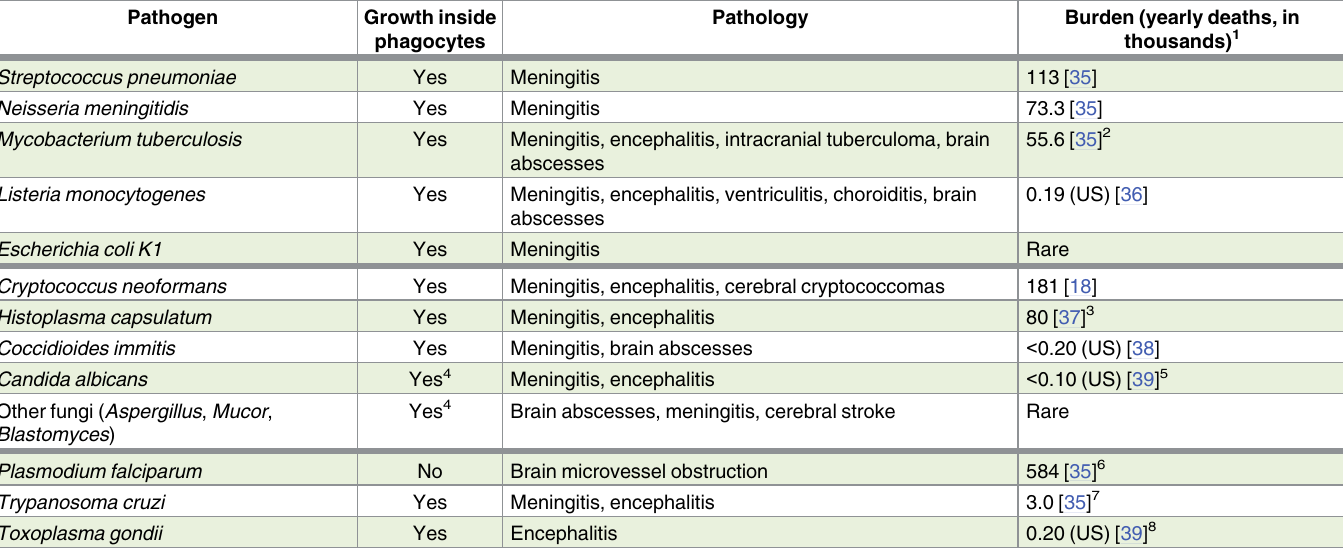
Table 1. Deaths due to CNS infection by select obligate and facultative intracellular microbes. Pathogen Growth inside